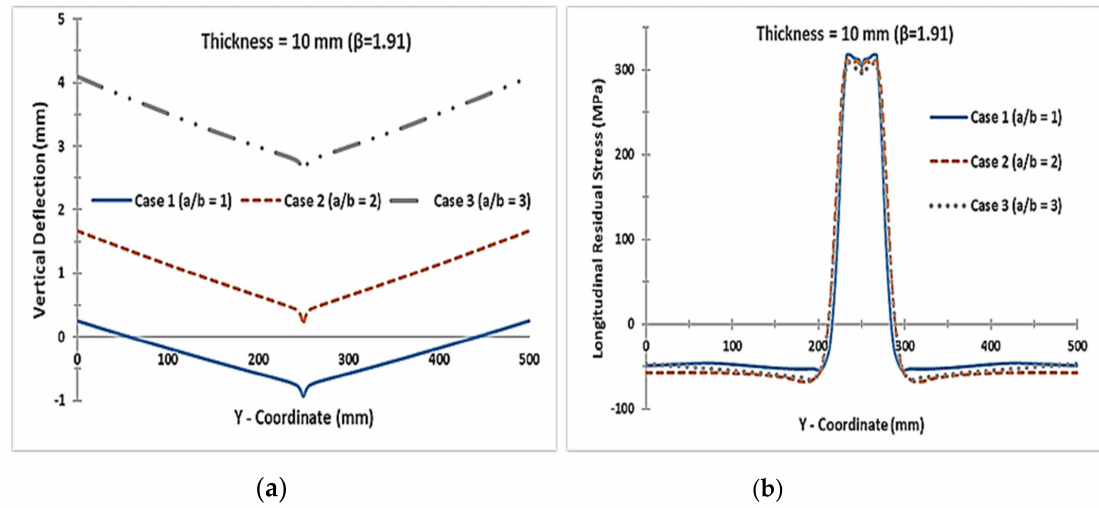
Figure 10. ( a ) Vertical deflection along line C-D and ( b ) longitudinal residual stress along line C-D. The longitudinal stress distribution through the plate panel breath at the mid-span of the model along line C-D on the bottom surface of 10 mm plate thickness ( t ) with a 1.91 plate slenderness ratio ( β ) for three different plate aspect ratios ( a / b ) 1, 2 and 3